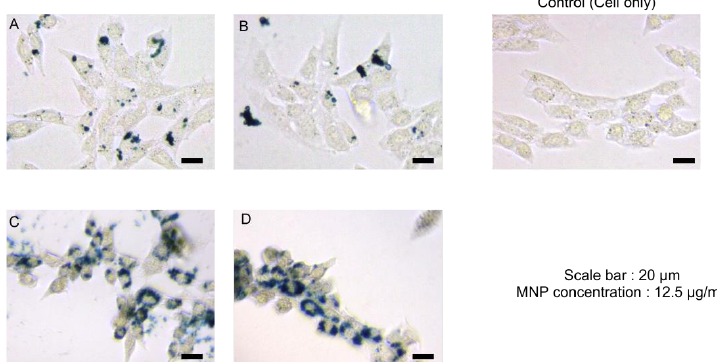
Figure 15. Optical micrographs of cells after the nanoparticle treatment. MNP uptake was shown by Prussian blue staining ( A ) CF-MNPs, ( B ) ZCF-MNPs ( C ) sodium citrate@ CF-MNPs, ( D ) sodium citrate@ ZCF-MNPs.